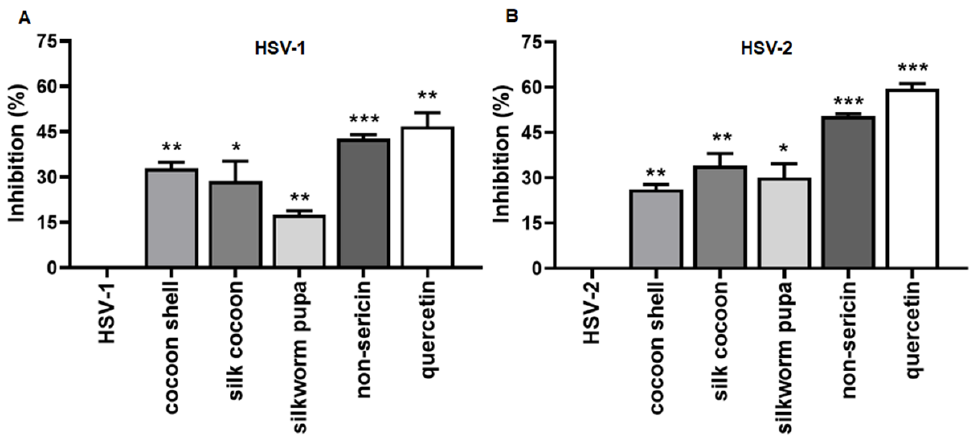
Figure 1. Effect of the extracts on HSV binding activity to the Vero cells. The extracts were treated into the cells at the same time with HSV-1 or HSV-2. The treated cells were incubated at 4 °C for 3 h to allow the virus to bind to the host cells. Extracts of cocoon shell, silk cocoon, silkworm pupa, non-sericin and quercetin were used at concentrations of 2.5 mg/mL, 1.25 mg/mL, 0.625 mg/mL, 0.625 mg/mL and 80 µg/mL in the study, respectively. The reduction of plaque formation was measured and represented as percentage of inhibition of HSV-1 ( A ) and HSV-2 ( B ) binding activity (* indicates p < 0.05; ** indicates p < 0.01 and *** indicates p < 0.001).